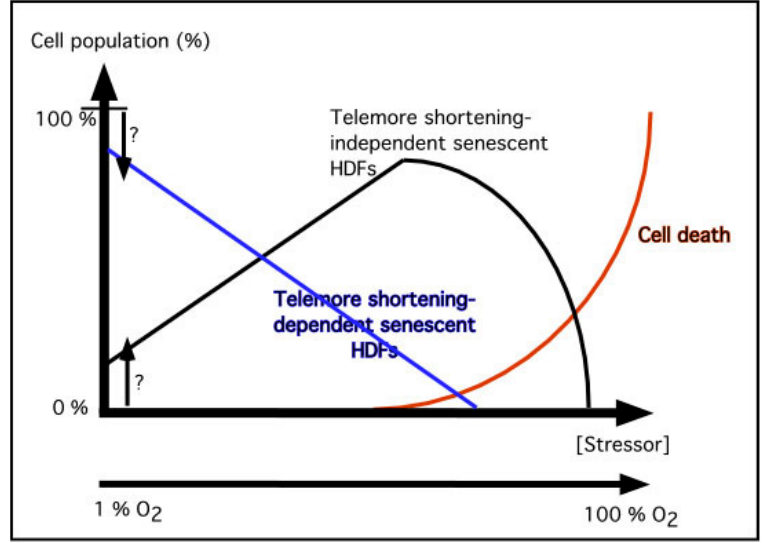
FIGURE 2. As stress increases, for instance from 1 to 100% O 2 , the proportion of cells in stress-induced premature senescence-like phenotype increases, and the proportion of cells which reached telomere-dependent replicative senescence decreases. Cell death increases as stress increases beyond subcytotoxic level. Since oxidative damage accumulates at physiological low O 2 partial pressures (damaged DNA bases are found in vivo in physiological conditions), a minority of telomere-independent senescent HDFs are likely to appear at low O 2 partial